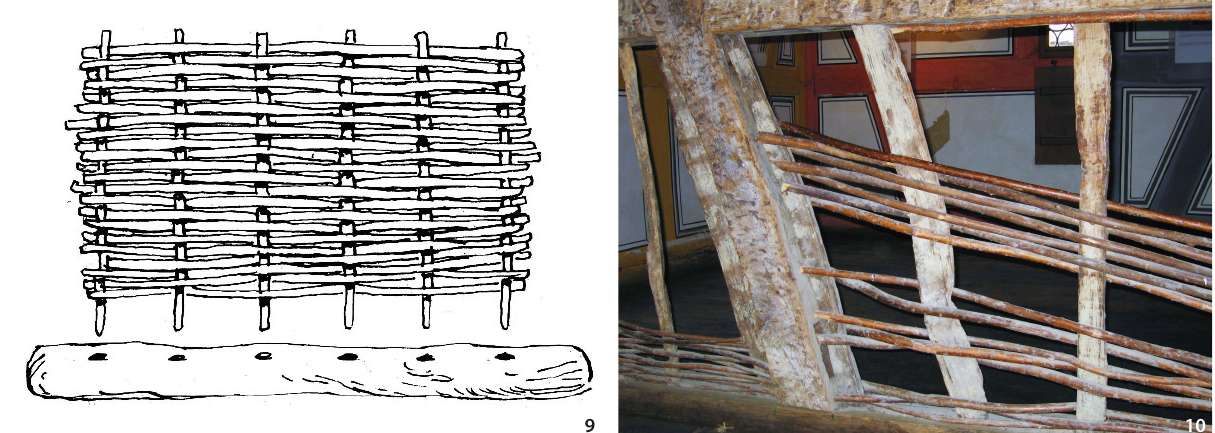
Figure 9 Wattling for wattle and daub in China (Source: Edwards 1984, 73). Figure 10 Hohenlohe Freilandmuseum, Germany. Wine grower's house from Sachsenflur, 1562, remains of a wattle and daub attic partition wall (Source: Miles